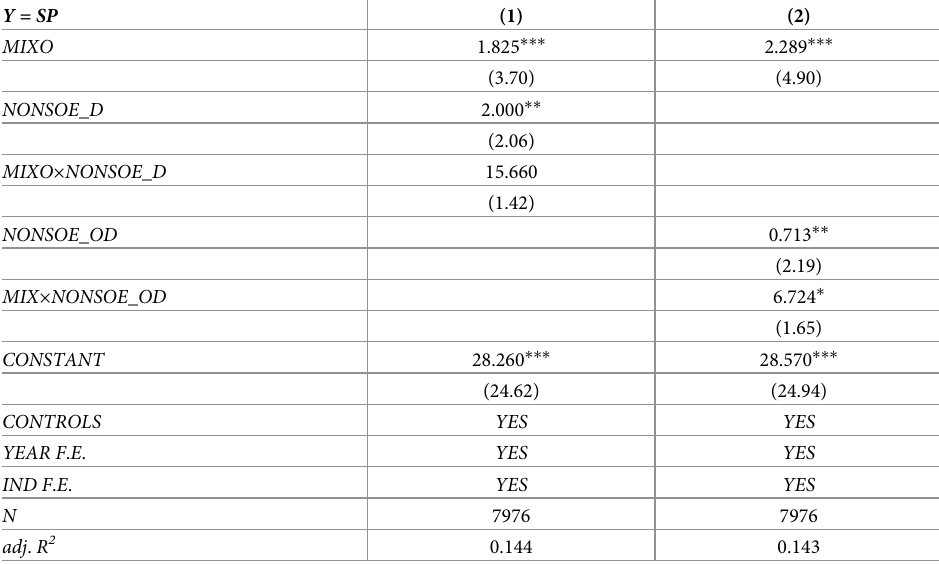
Table 11. The test of the synergy effect